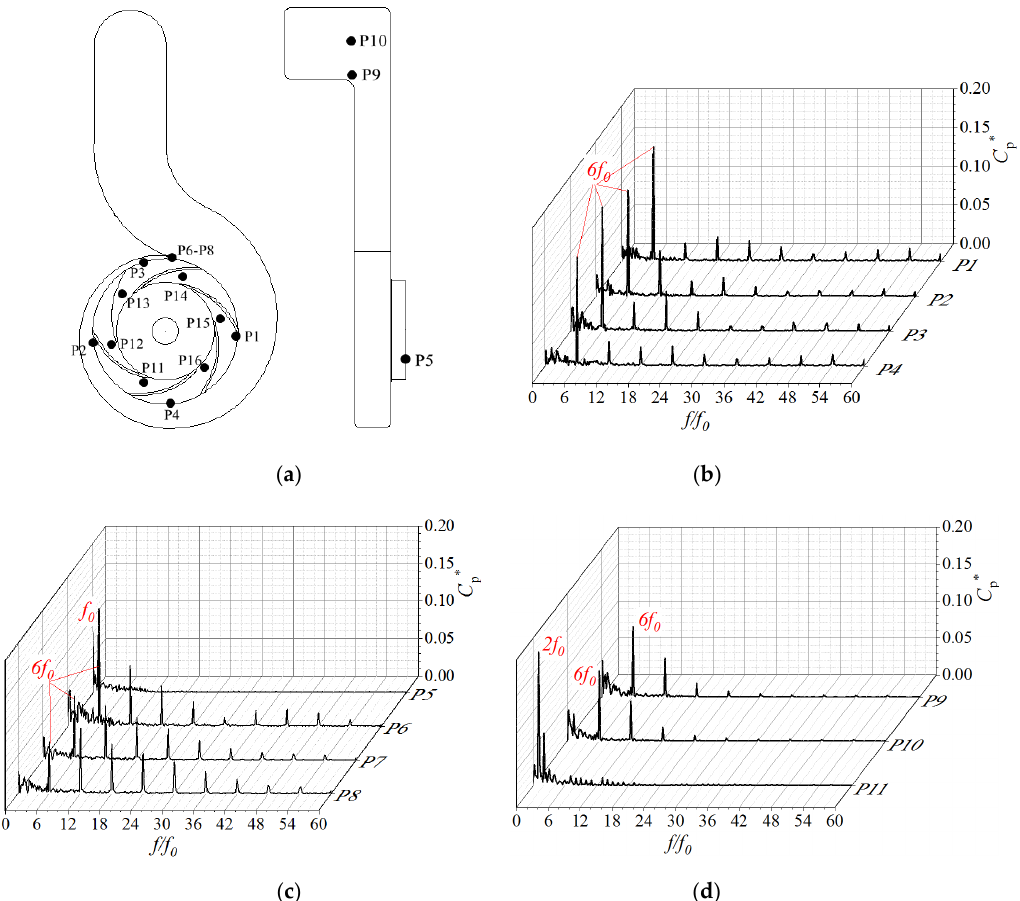
Figure 15. Spectrum of pressure fluctuation in the cooling pump at Q r : ( a ) monitoring points location; ( b ) pressure spectrum of P1–P4; ( c ) pressure spectrum of P5–P8; ( d ) pressure spectrum of P9–P11.